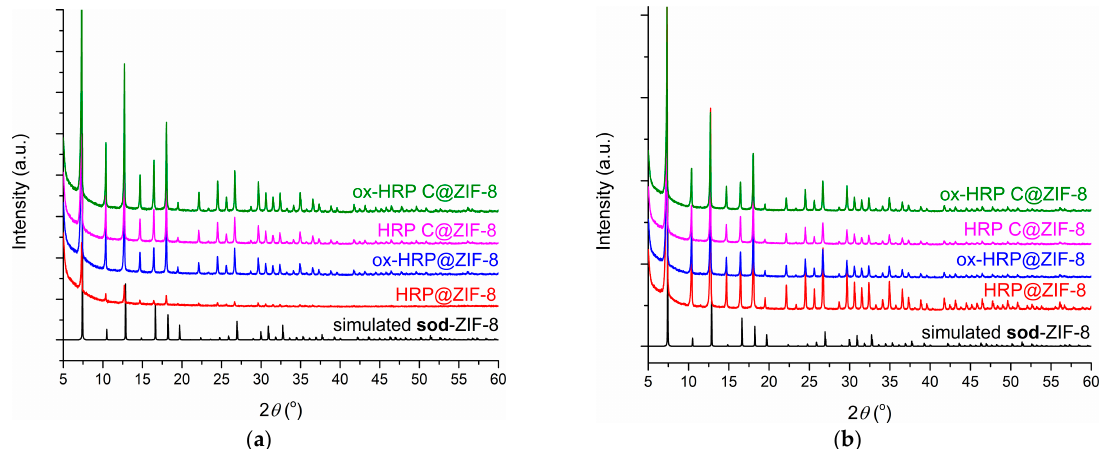
Figure A4. ( a ) Simulated PXRD pattern of the sod ‐ ZIF ‐ 8 and experimental PXRD patterns of the biocomposite samples washed only with water after incubation at 60 °C for 1 h; ( b ) Simulated PXRD pattern of the sod ‐ ZIF ‐ 8 and experimental PXRD patterns of the biocomposite samples washed with water and a 1 M NaCl solution after incubation at 60 °C for 1 h.